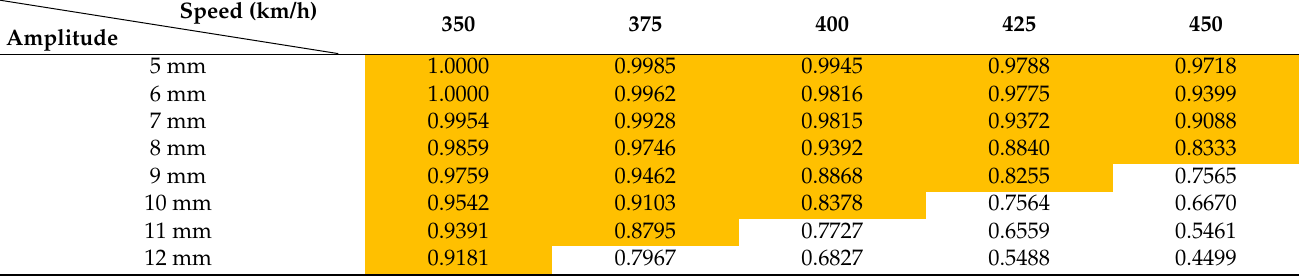
Table 3. Reliability of vehicle vertical safety at 350 km/h and above for VCVP of